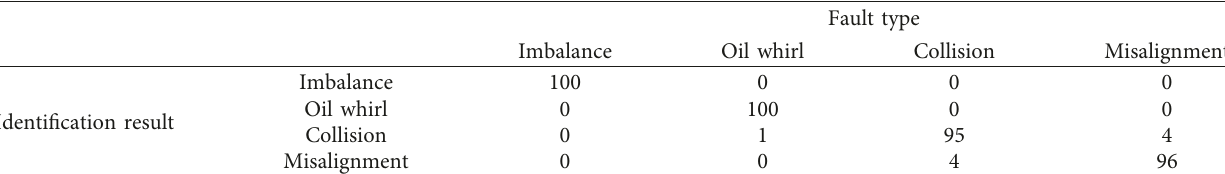
Figure 11: SDP image without illusive components. (a) Imbalance. (b) Whirl. (c) Misalignment. (d) Rubbing. Table 4: Classification